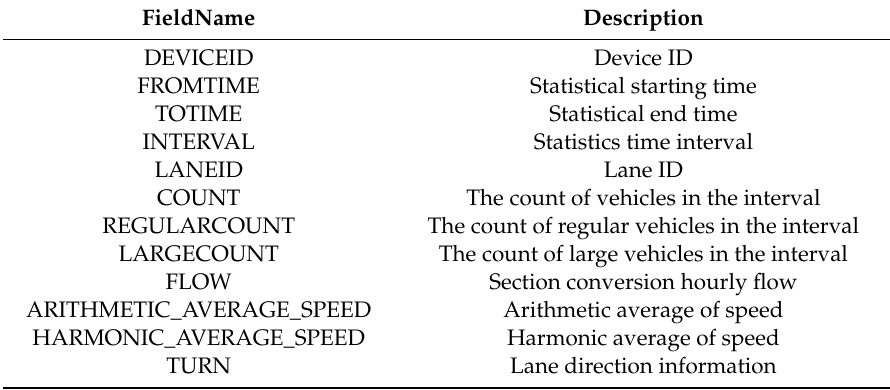
Table 1. The main fields of the